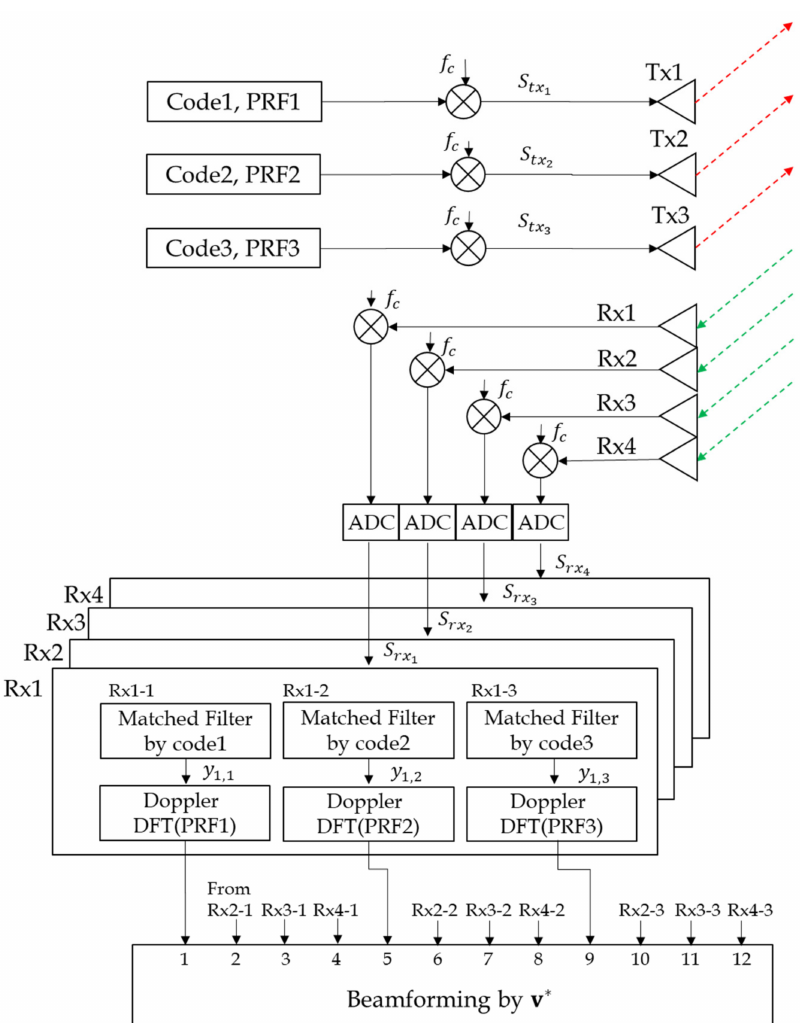
Figure 2. Block Diagram of MIMO Signal